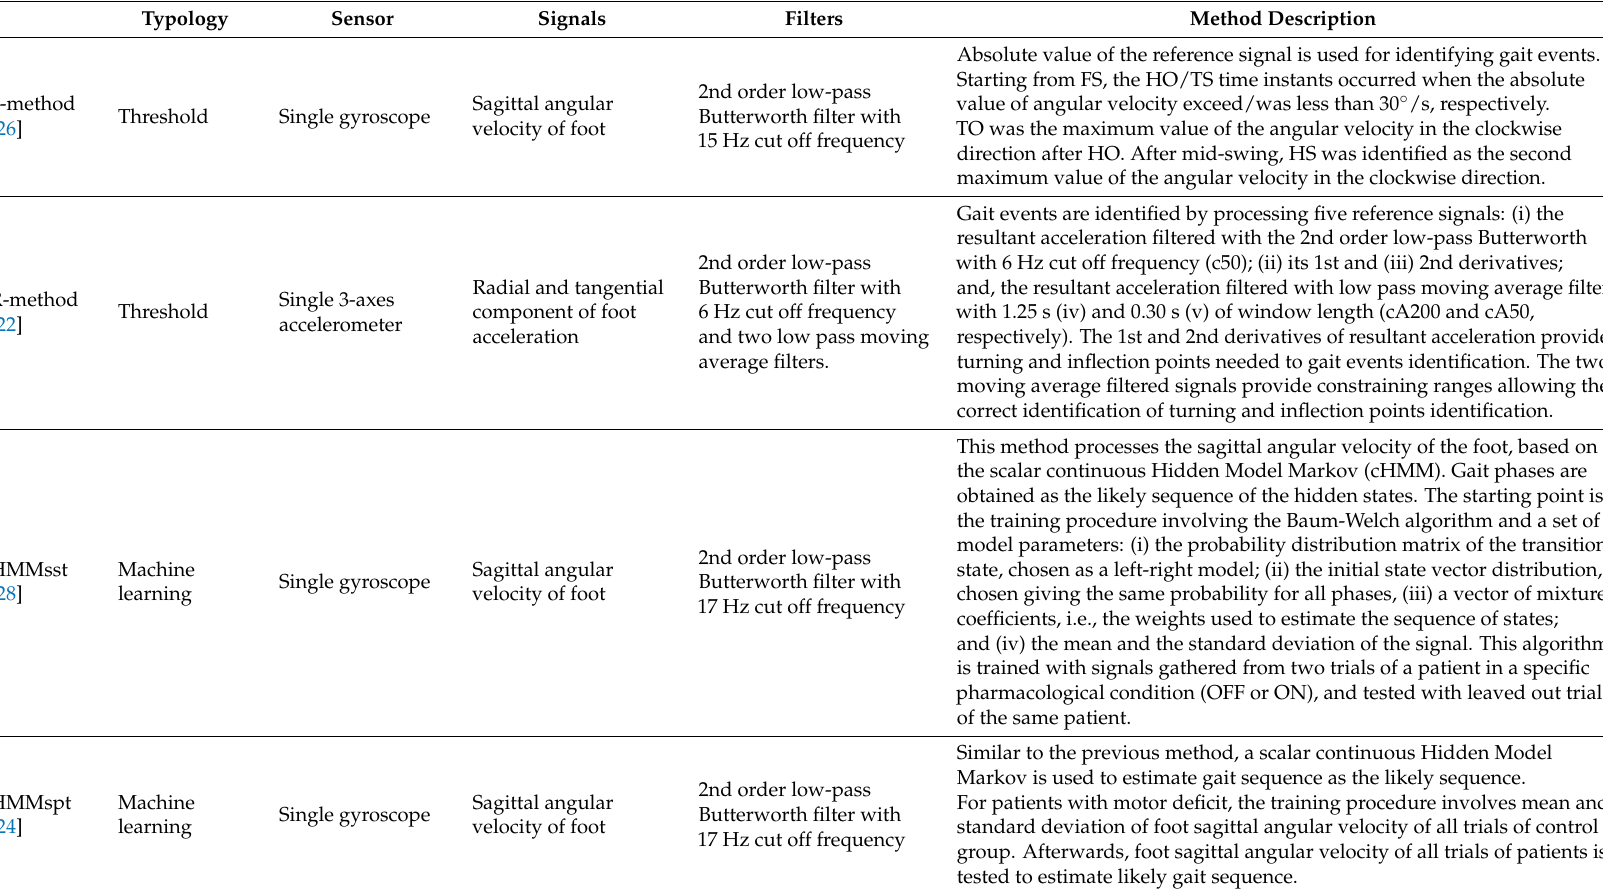
Table 2. Brief description of the gait partitioning methods adopted in this comparative